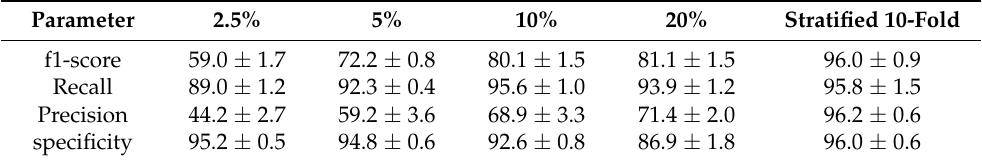
Table 3. Results (mean ± standard deviation %) of the imbalanced nested cross-validation at four different prevalence rates and stratified nested 10-fold Cross-validation using the complete feature set.